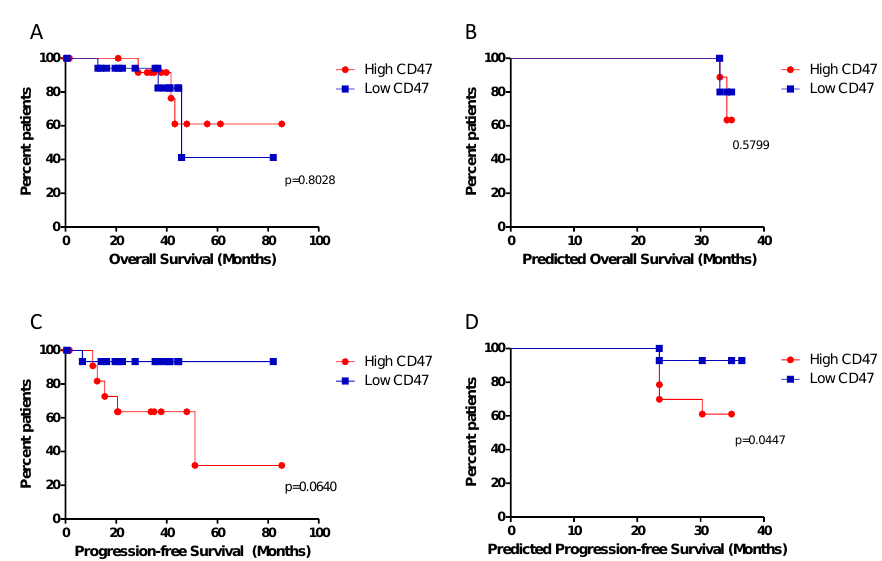
Figure 2. ( A ) Kaplan – Meier curve for overall survival in patients with different CD47 expression levels; ( B ) Kalan – Meyer curve for overall survival in patients with different CD47 expression levels after correcting for the presence of BAP1, GNAQ, and GNA11 mutations; ( C ) Kaplan – Meier curve for progression-free survival in patients with different CD47 expression levels; ( D ) Kaplan – Meier curve for progression-free survival in patients with different CD47 expression levels after correcting for the presence of BAP1, GNAQ, and GNA11 mutations.